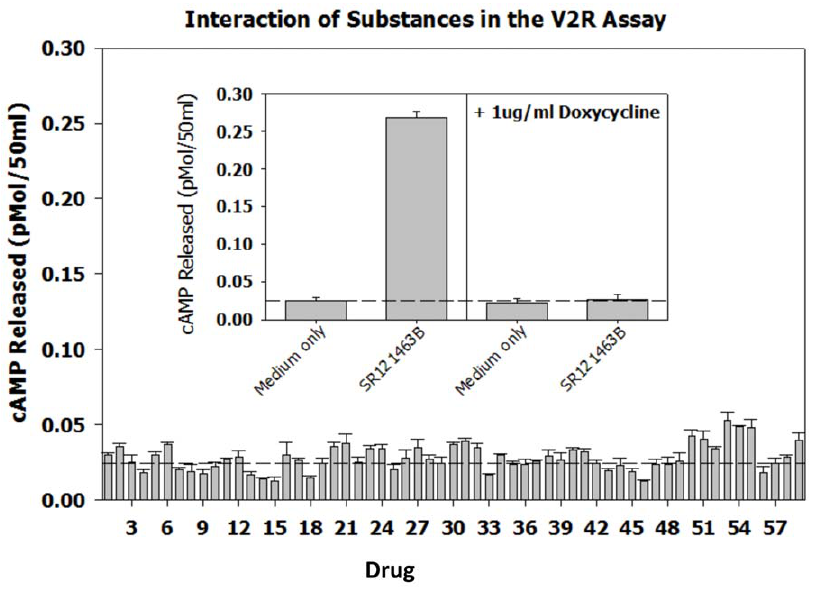
Figure 9. Performance of non-specific (expected negative controls) and positive controls for the V2R pharmacoperone assay. The non-specific compounds were selected from reagents that alter the level of cyclic nucleotides, block Ca2 + and Na channels, inhibit calmodulin, inhibit transcription, activate a range of receptors, cross link membrane proteins and otherwise perturb the cell. The dotted lines parallel to the X-axis show the response of the cells in the presence of medium only (i.e., no added drugs). The drugs, used at a concentration of 1 m g/ml were: 1. Urotensin II (neurosecretory peptide); 2. Octreotide Related Peptide; 3. Somatostatin; 4. Bombesin; 5. Calcitonin (salmon); 6. Growth Hormone Releasing Factor; 7. Thyrotropin Releasing Factor; 8. Galanin (human); 9. NPSF-Amide (SLAAPQRF-NH2); 10. Neuromedin U (rat); 11. BI 679 (the growth hormone releasing peptide, hexarelin); 12. Adiponectin (a hormone with broad impact on metabolism); 13. 1-(3-Dimethylaminopropyl)-3-Ethylcarbodiimide (a water- soluble protein crosslinker); 14. O2 9 -Monosuccinyl Guanosine 3 9 -5 9 -Cyclic Monophosphate Tyrosine Methyl Ester (cGMP analog); 15. 1-Ethyl-3-(3- Dimethylamino-Propyl)Carbodiimide-HCl (a water-soluble protein crosslinker); 16. D- b -3,4-dihydroxy-Phenylalanine (D-DOPA); 17. L-Noradrenaline; 18. Trifluoperazine (calmodulin antagonist); 19. Histone (from calf thymus) Type II-S (a basic protein); 20. N6-2 9 -O-Dibutyryladenosine 3 9 -5 9 -Cyclic Monophosphate (a cAMP analog); 21. Spermine; 22. Ouabain Octahydrate (Strophanthin-G) (sodium ion channel antagonist); 23. 3-Hydroxytyramine; 24. p-Nitrophenyl Phosphate; 25. 8-(4-Chlorophenylthio)-Adenosine 3 9 :5 9 -Cyclic Monophosphate; 26. Carbonyl Cyanide m-Chlorophenylhydrazone; 27. Guanosin-5 9 -triphosphate; 28. Adenylyl-imidodiphosphate (AMP-PNP); 29. p-Nitrophenyl- b -D-Galactopyranoside; 30. Cytochrome-C; 31. Concanavalin A (a plant lectin that interacts with plasma membrane glycoproteins); 32. L-1-Tosylamide-2-Phenyl-Ethylchloromethyl Ketone (inhibitor of trypsin-like enzymes); 33. Actinomycin D (transcription inhibitor); 34. b -Nicotinamide Adenine Dinucleotide ( b -NAD); 35. Adenosine 5 9 - Monophosphoric Acid; 36. Nifedipine (Ca2 + ion channel antagonist); 37. D600 (Ca2 + ion channel antagonist); 38. 2-n-Propyl-Amino-indine; 39. Veratrine (Na channel inhibitor); 40. Vinblastine (microtubule inhibitor); 41. Cytochalasin D (blocks cellular actin polymerization); 42. Polyinosinic- Polycytidylic Acid (Poly[I]-Poly[C]) polymer; 43. Forskolin (activator or adenylate cyclase); 44. A23187 (Ca2 + ionophore); 45. SQ23,377 Ionomycin (Ca2 + ionophore); 46. U-73343 (inhibitor of inositol phosphate metabolism); 47. Creatine Kinase; 48. Deferoxamine Mesylate (metal chelator); 49. Flavin Mononucleotide; 50. [-]-Norepinephrine; 51. Adenosine-3,5 9 -Cyclic Monophosphothioate, Rp-Isomer; 52. N-nitro-L-arginine L-NAME Methyl Ester;